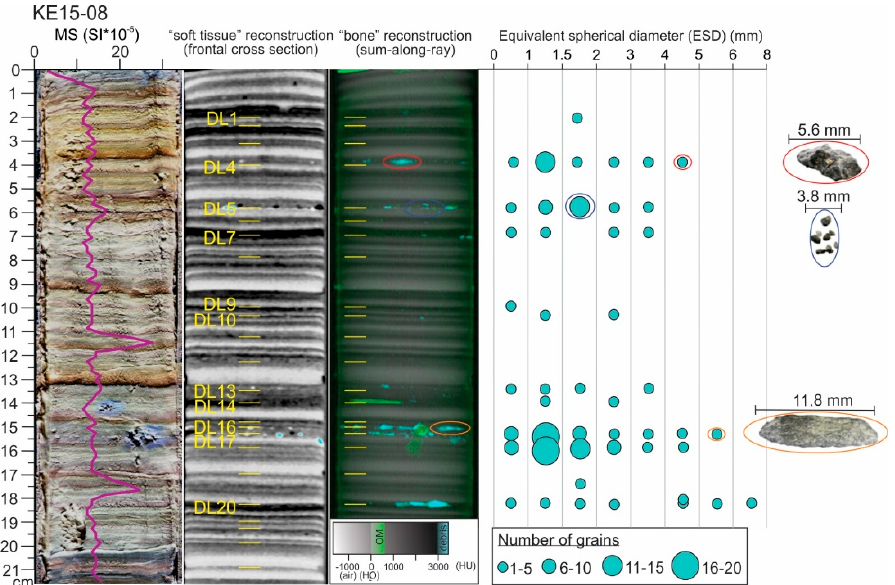
Figure 2. From left to right: Photograph of core KE15-08 with enhanced colour histogram to increase the visibility of the varves with a superimposed record of magnetic susceptibility (MS) in purple. Frontal cross -section of the “soft tissue” reconstructed image. X-ray computed tomography (CT) “sum-along-ray” (equivalent to inverted radiograph) image of the “bone” reconstructed image stack of the same core; laminated (varved) mud is shown in grey scale (intermediate HU), debris in blue (high HU), and organic material in green (low HU). Each layer that contains debris in this core is labelled by DL (debris lamina) and the layer number. The number of grains per equivalent spherical diameter (ESD) class is shown on the right. Pictures of selected grains from three layers.